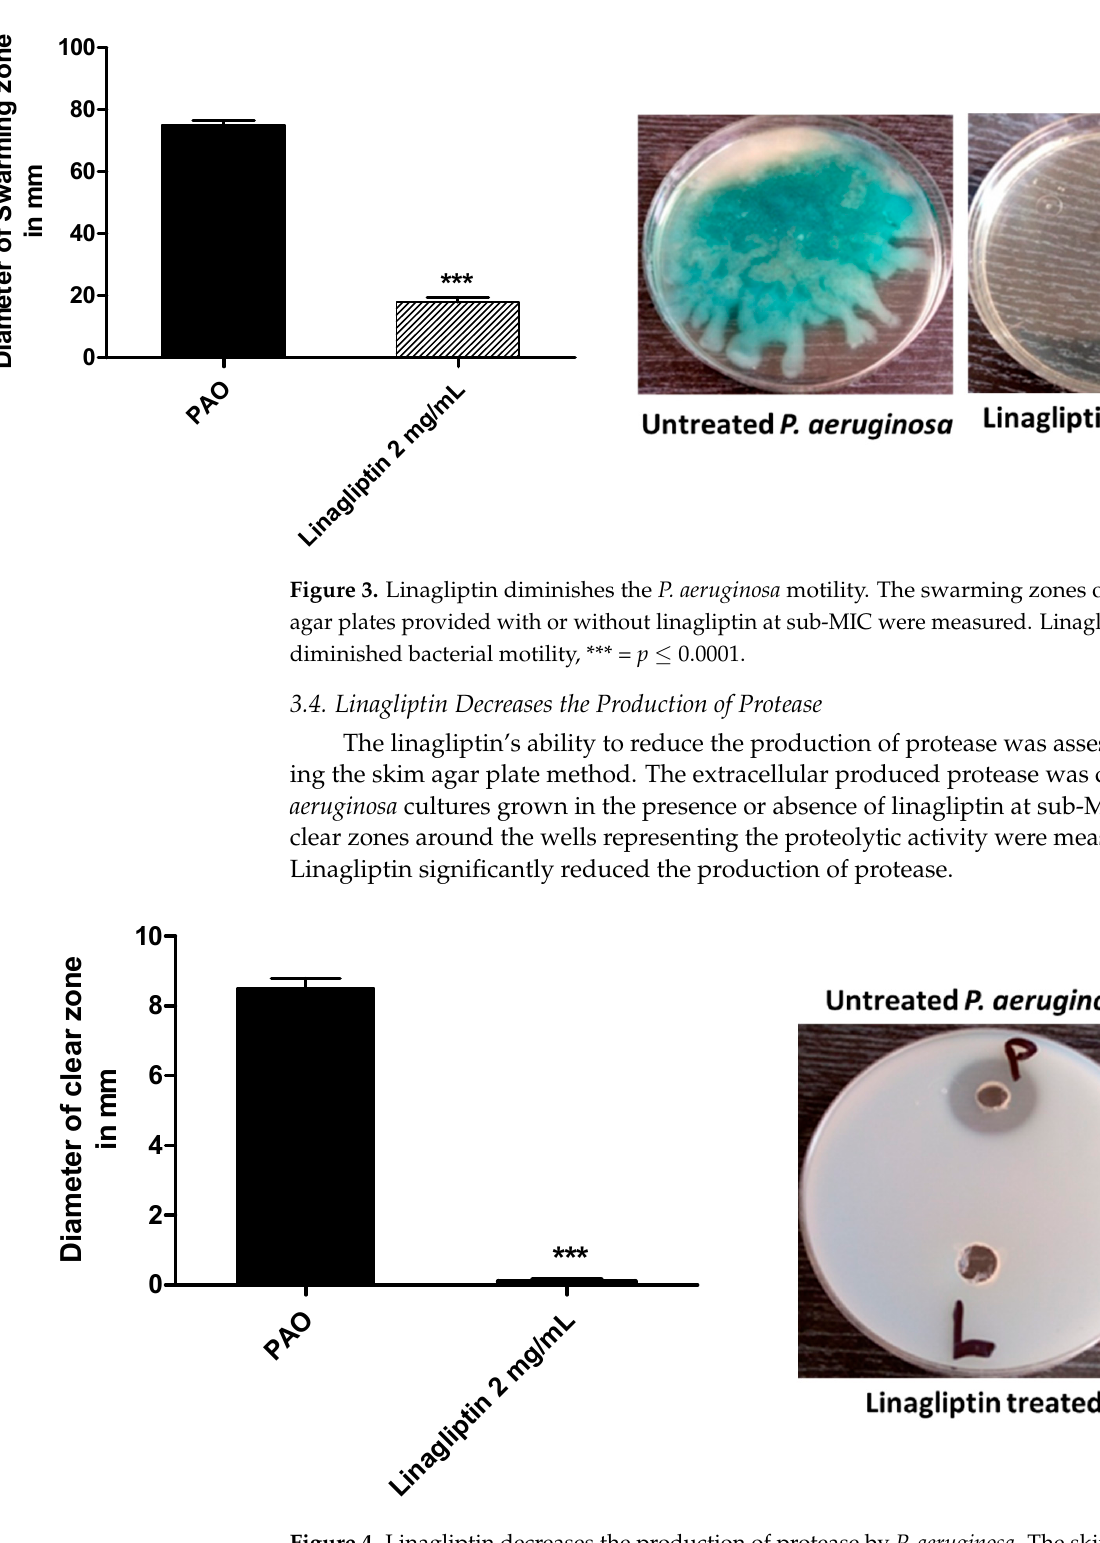
Figure 4. Linagliptin decreases the production of protease by P. aeruginosa . The skim milk agar plate method was used to assess the effect of linagliptin on the production of linagliptin. P. aeruginosa was grown in the presence or absence of linagliptin at sub-MIC, and the supernatants containing the extracellular protease were collected. Aliquots from supernatants were placed in performed wells and the clear zones were measured after overnight incubation. Linagliptin significantly reduced the production of protease, *** = p ≤ 0.0001.